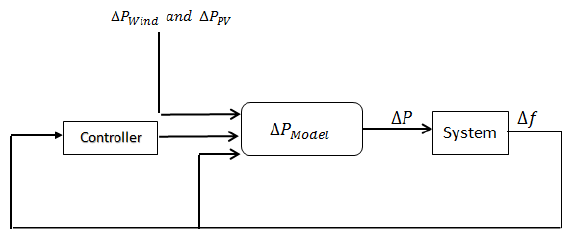
Figure 5. Proposed controller.